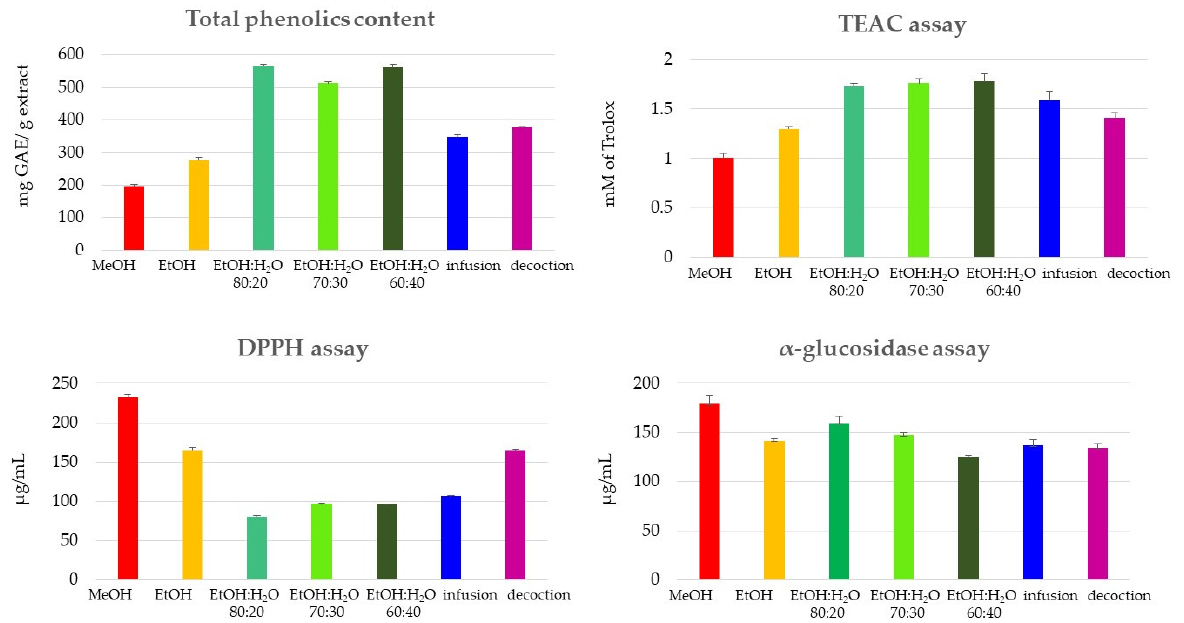
Figure 5. Phenolic content, TEAC, DPPH, and α -glucosidase assays of MeOH and green extracts of C. cardunculus subsp. scolymus , cultivar “Carciofo di Paestum” PGI. 2.8. α -Glucosidase Inhibitory Activities of “Carciofo di Paestum” PGI